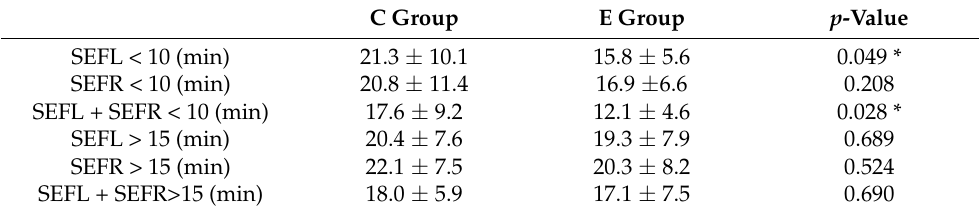
Figure 6. Duration of SEF < 10 or SEF > 15. SEF, spectral edge frequency; SEFL, SEF of left brain; SEFR, SEF of right brain; SEFL + SEFR, figure simultaneously representing SEFL and SEFR < 10 or >15; * p < 0.05. Table 4. SEF characteristics during anesthesia.